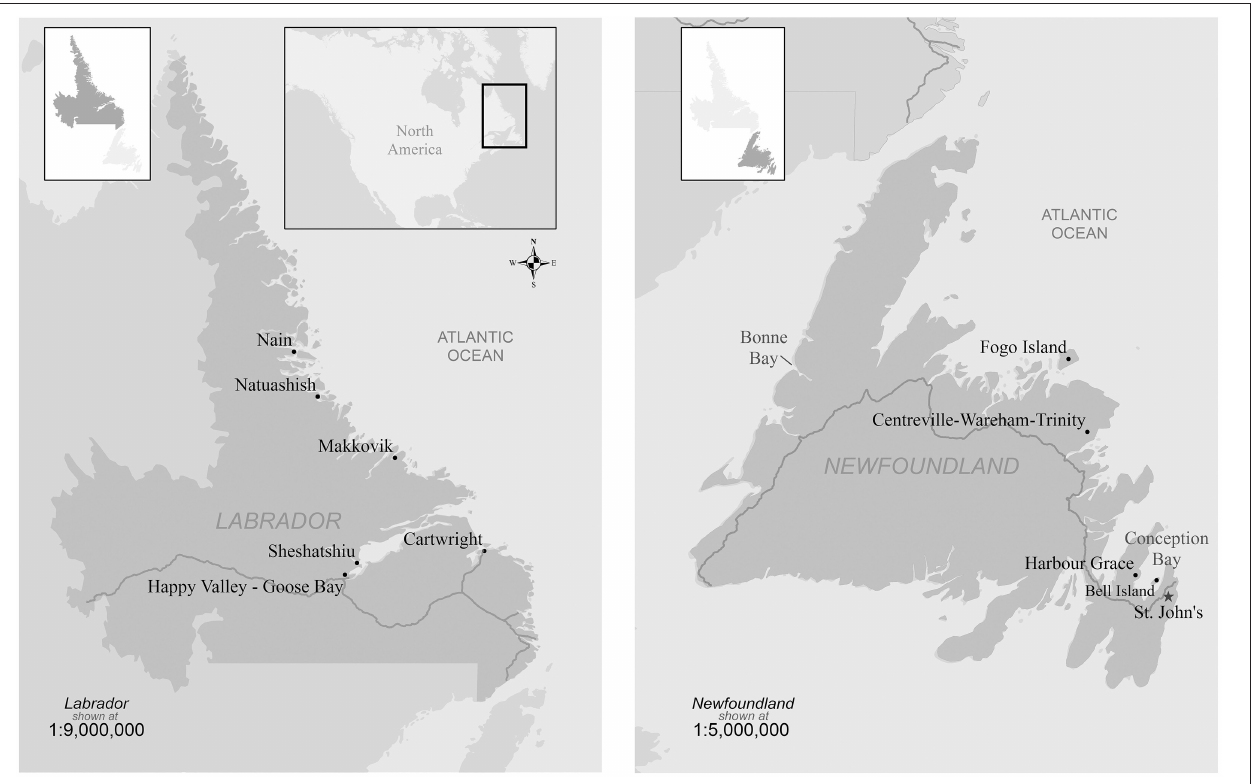
FIGURE 1 | Map of province of Newfoundland and Labrador,